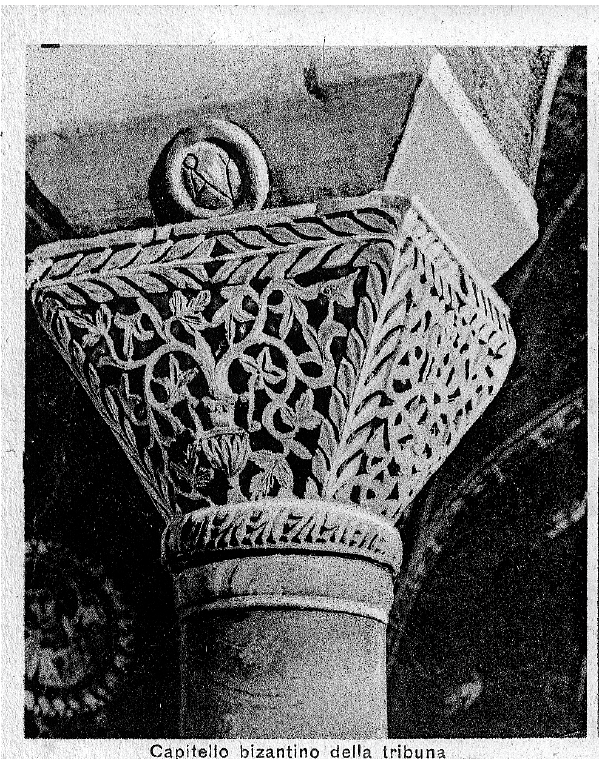
Figure 13. Impost block with Julian’s monogram, San Vitale, Ravenna (photo: courtesy of Istituzione Biblioteca Classense, Ravenna, Fondo